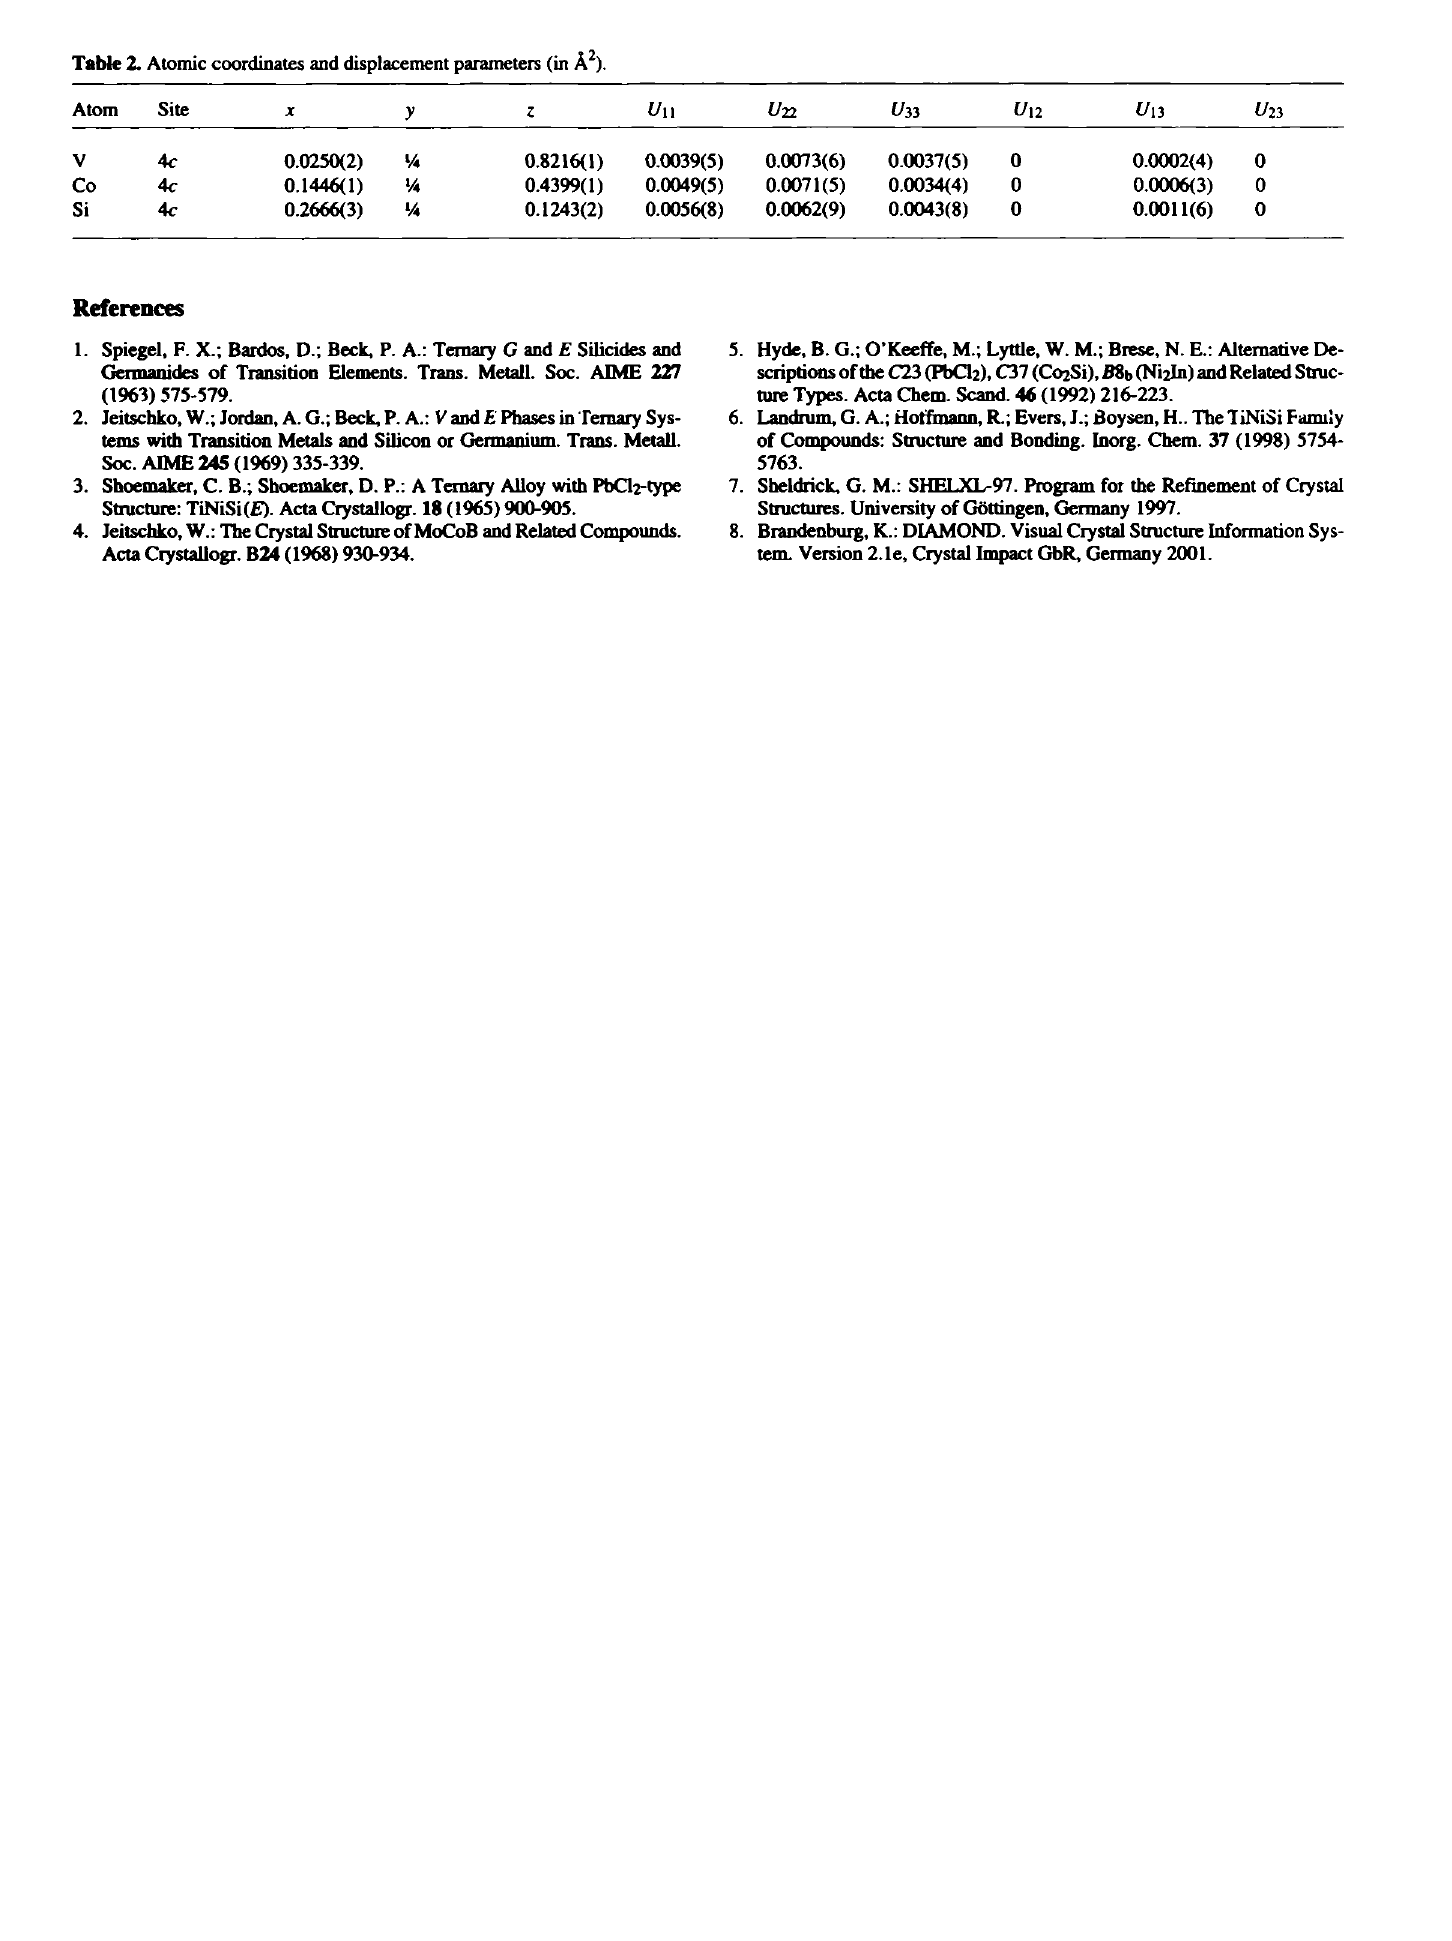
Table 2. Atomic coordinates and displacement parameters (in Ä 2